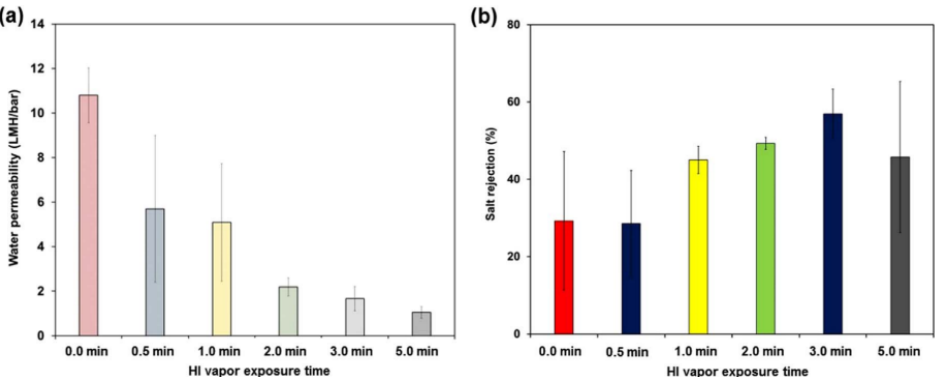
Figure 16. ( a ) Water and ( b ) salt rejection of GO membranes, diagram taken from [150].